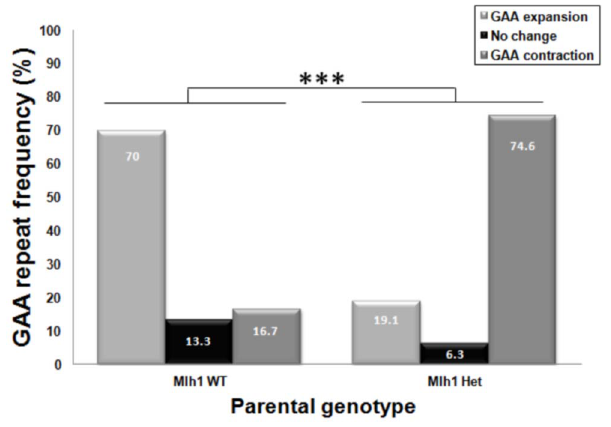
Figure 2. Intergenerational GAA repeat frequencies. Analysis of intergenerational transmission of GAA repeat expansion frequency based on the parental genotype (WT=GAA + / Mlh1 + / + , Het=GAA + / Mlh1 + / 2 ). Frequencies of ‘GAA expansions’, ‘no change’ and ‘GAA repeat contractions’ transmitted to offspring are represented as percentages of total GAA repeat transmissions. Chi squared ( x 2 ) statistical testing was applied to this expriment. WT n=30 GAA PCR products from 10 mice; Het n=63 GAA PCR products from 21 mice; ***=p , 0.001.